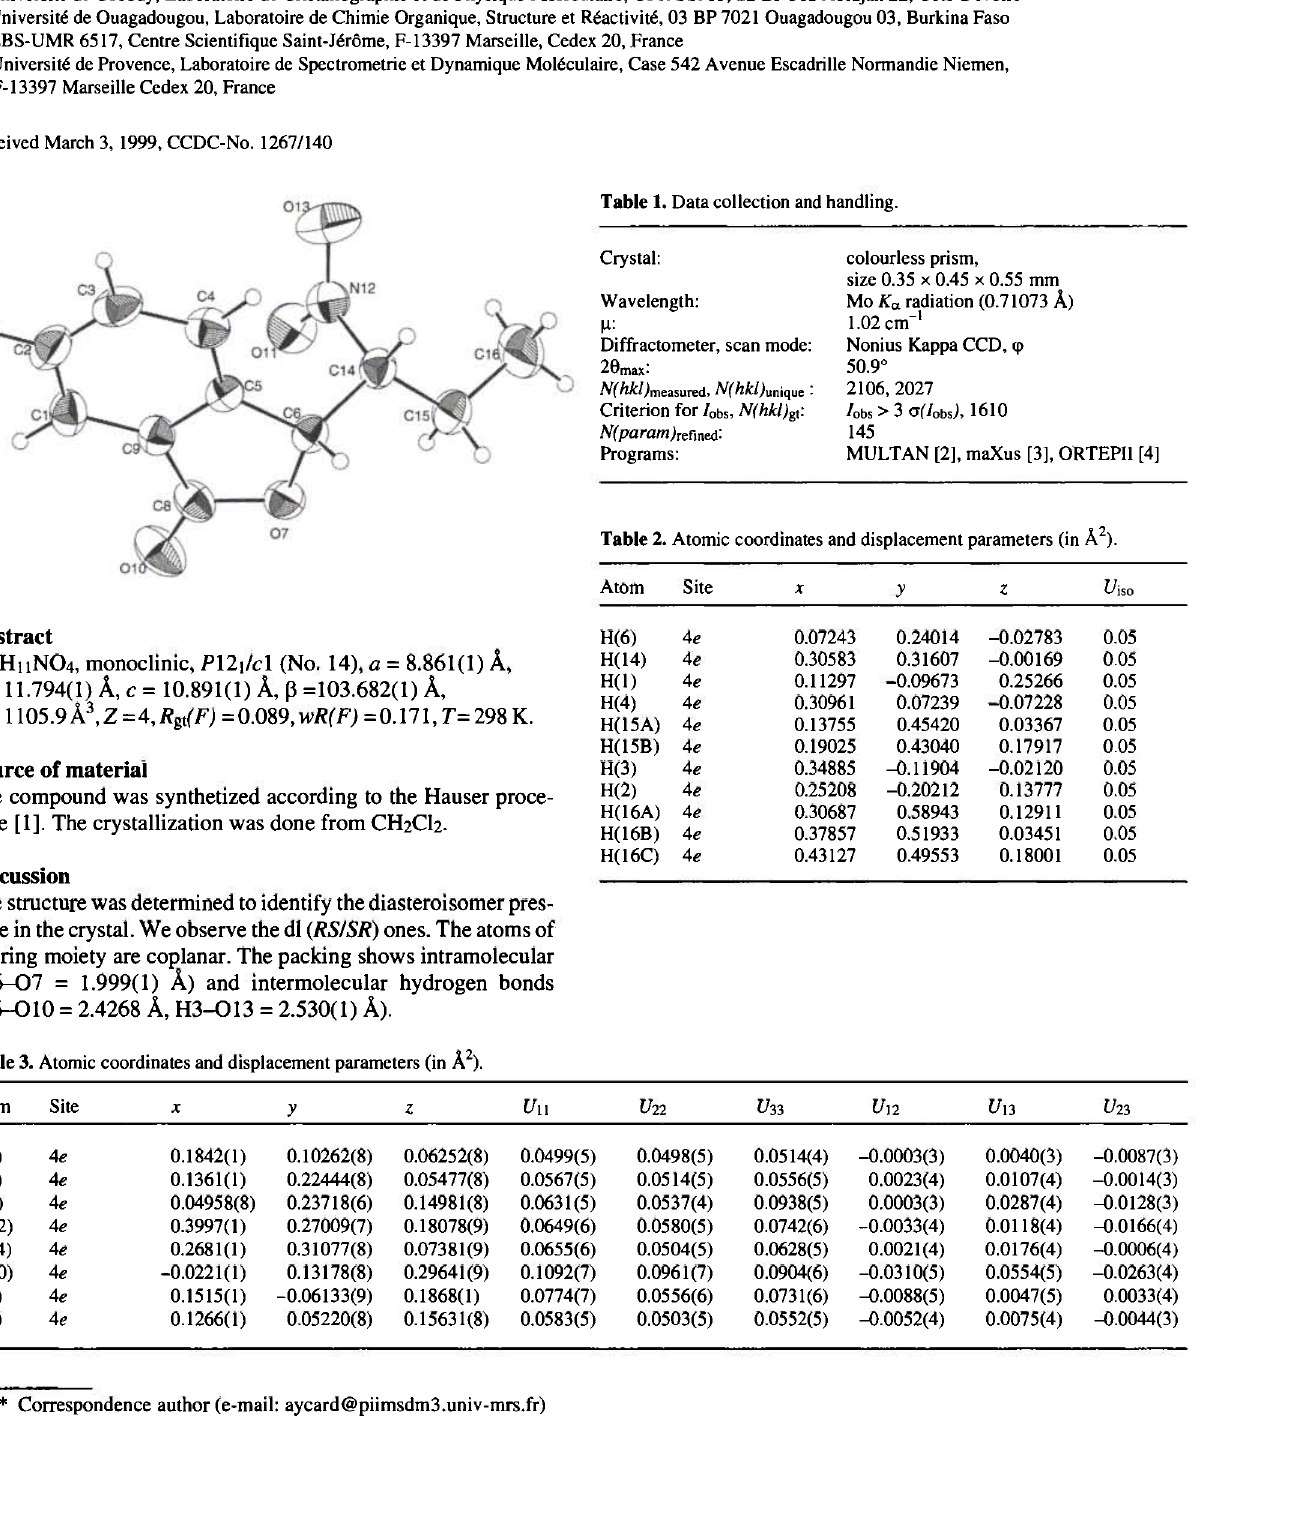
Table 3. Atomic coordinates and displacement parameters (in Ä 2 ).